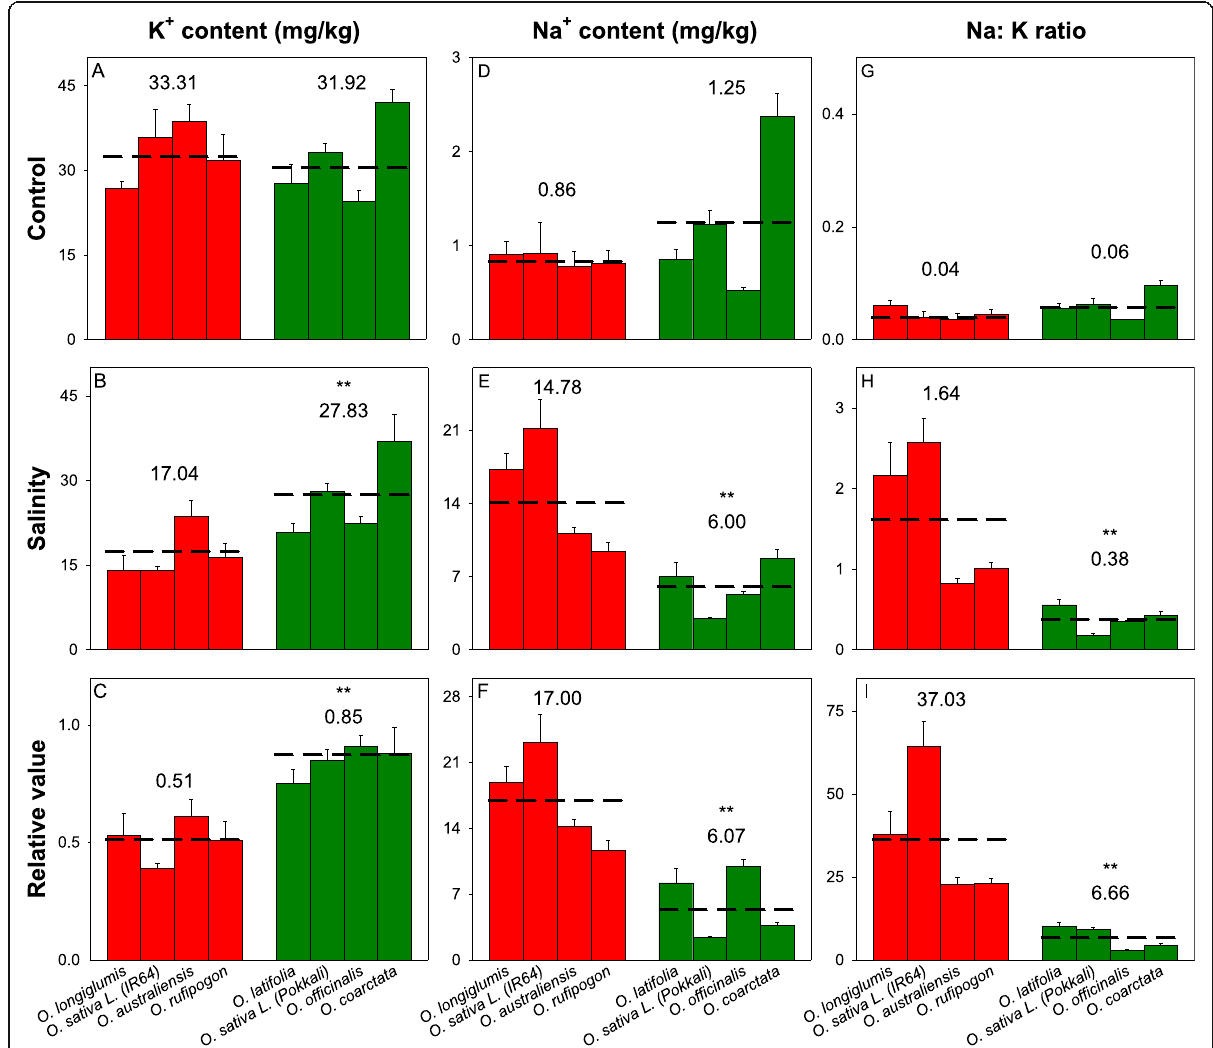
Fig. 5 Leaf ion contents in six wild and two cultivated rice lines after 6 weeks of 100 mM salinity treatment. ( A-C ) leaf K + contents, ( D-F ) leaf Na + contents and ( G-I ) leaf Na + /K + ratios. Data are mean values and the error bars indicate the standard errors. * and ** indicates significant difference found between sensitive and tolerant groups at P < 0.05 and P < 0.01, respectively, using independent sample t-test. The number and dashed lines indicate the mean values of each group. The data are means and the error bars indicate the standard